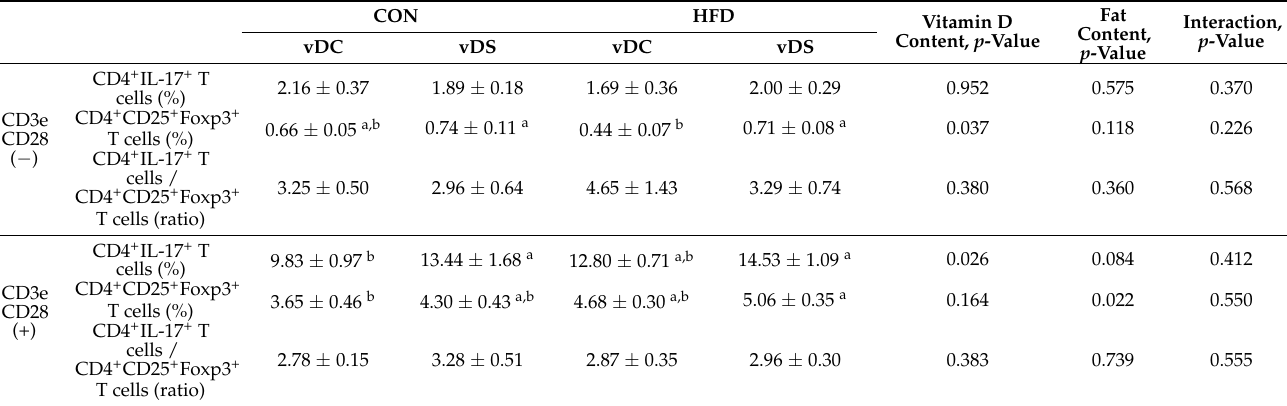
Table 4. Populations of CD4 + IL-17 + T cells and CD4 + CD25 + Foxp3 + T cells. CON HFD Vitamin D